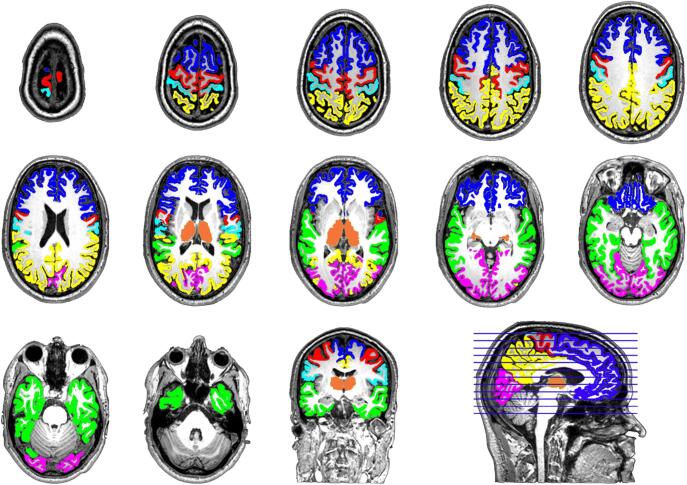
Cortical regions of interest (ROIs) and thalamus for a representative participant, displayed on the participant’s T1 image in horizontal view on multiple slices from superior to inferior. Masks based on Freesurfer’s automatic parcellation were combined to create an initial thalamus mask and six cortical ROI masks: prefrontal cortex (blue), motor cortex (red), somatosensory cortex (cyan), posterior parietal cortex (yellow), temporal cortex (green), and occipital cortex (magenta). The initial thalamus mask was then manually edited to include the lateral and medial geniculate nuclei to form the final thalamus mask (orange). These masks were then used in probabilistic tractography analyses to quantify thalamocortical connectivity. (For interpretation of the references to colour in this figure legend, the reader is referred to the web version of this article.)